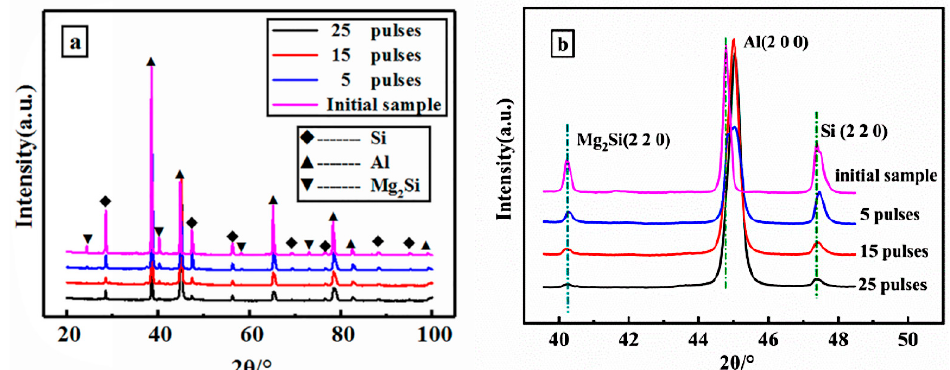
Figure 4. The X-ray diffractometer (XRD) diffractograms of Al–20Si–5Mg alloy surface before and after HCPEB treatment: ( a ) XRD diffractograms; ( b ) local enlargement of ( a ).